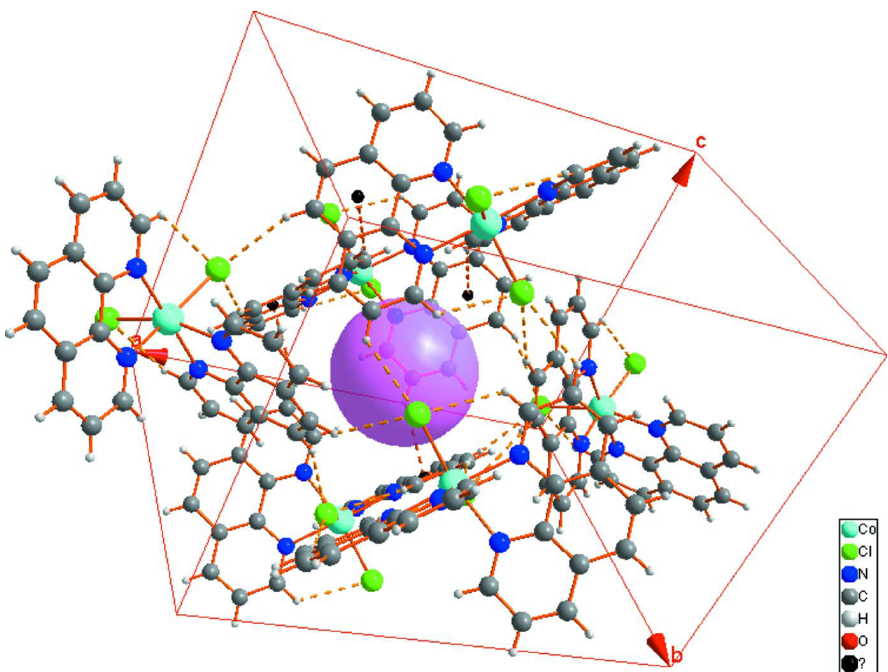
Figure 2 Crystal packing of (I) showing the cavity (represented by the pink sphere) created by the C—H···Cl and C—H··· π interactions with hydrogen bonds drawn as dashed